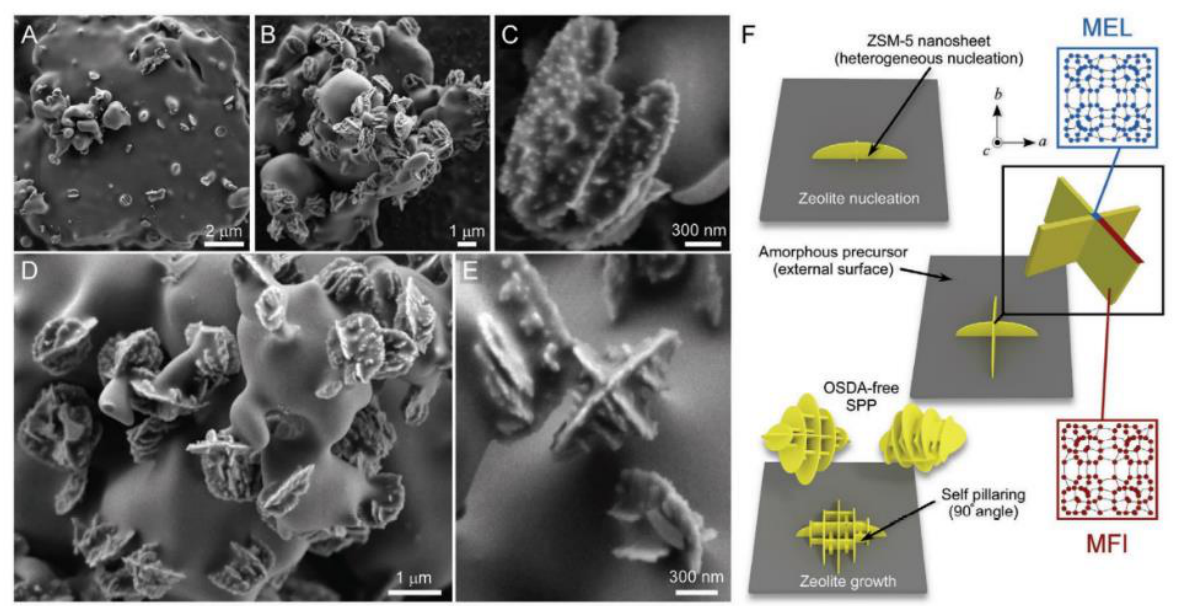
Figure 5. FE-SEM images of solids at different time with ( A )1 d, ( B ) 2 d and ( C ) 3 d; ( D , E ) higher- magnification images of solids heated at 2 d; ( F ) schematic representation of heterogeneous nucleation and growth of SPP zeolites on amorphous interfaces. Reprinted with permission from ref. [120]. Copyright 2021, Wiley.